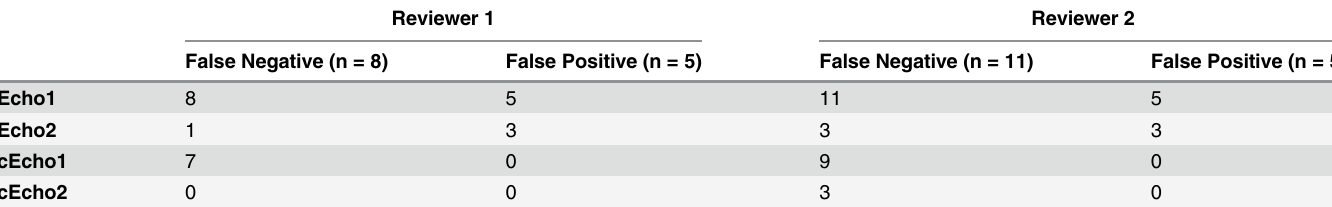
Table 3. A summary of false negative and positive cases stratified by the individual echo